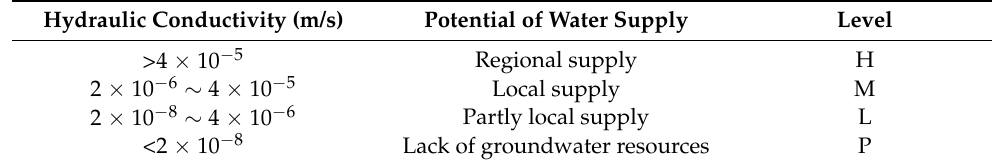
Table 4. Hydraulic conductivity classes (modified from Reference [54]).